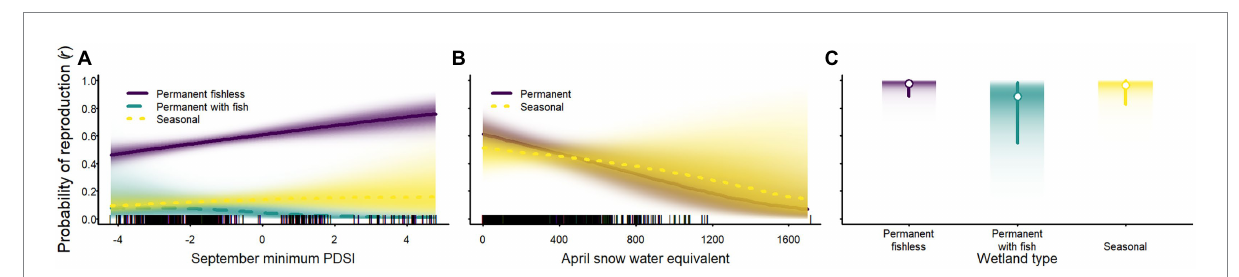
FIGURE 7 Probability of reproduction for Sierra Nevada yellow-legged frogs [ Rana sierrae ; (A) ], Yosemite toads [ Anaxyrus canorus ; (B) ], and sierran treefrogs [ Pseudacris sierra ; (C) ] in relation to the minimum Palmer Drought Severity Index (PDSI) in September (A) , April snow water equivalent [SWE; (B) ], and site type (indigo shading and solid line = permanent [and fishless for panels (A,C) ]; aqua shading and dashed line = permanent with fish; gold shading and dotted line = seasonal) in Yosemite National Park, California, United States, 2007–2021. Lines represent posterior modes and shading intensity represents the posterior probability distribution. In (C) , white circles represent posterior modes, vertical lines represent 95% highest posterior density intervals, and the intensity of shading represents posterior probability densities.